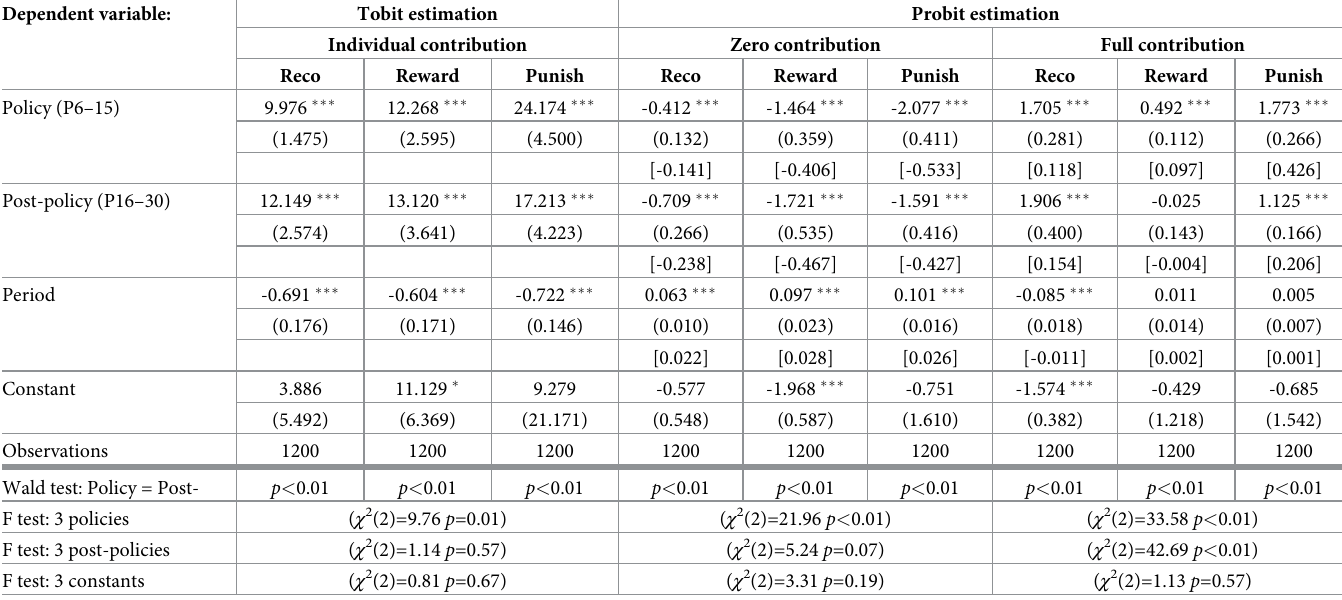
Table 3. Determinants of